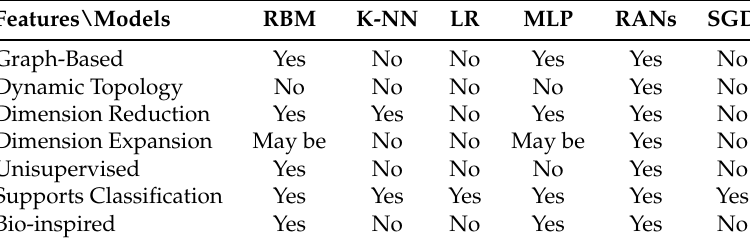
Table 7. Feature based comparative study of RANs with five modeling